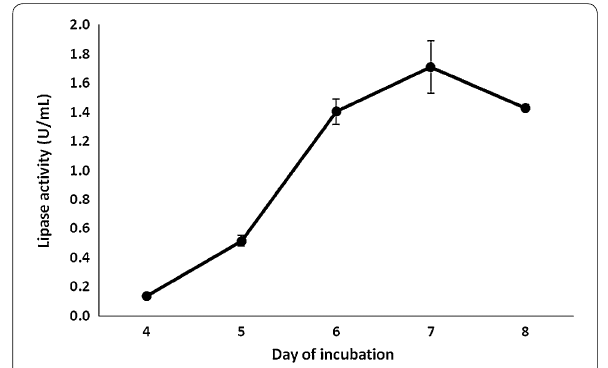
Fig. 1 Lipase activities of the culture supernatants of T. lentiforme ACCC30425 growing in the inducing medium with olive oil as the sole carbon source. The lipase activities were assayed using spectrophotometric method with p NPP as the